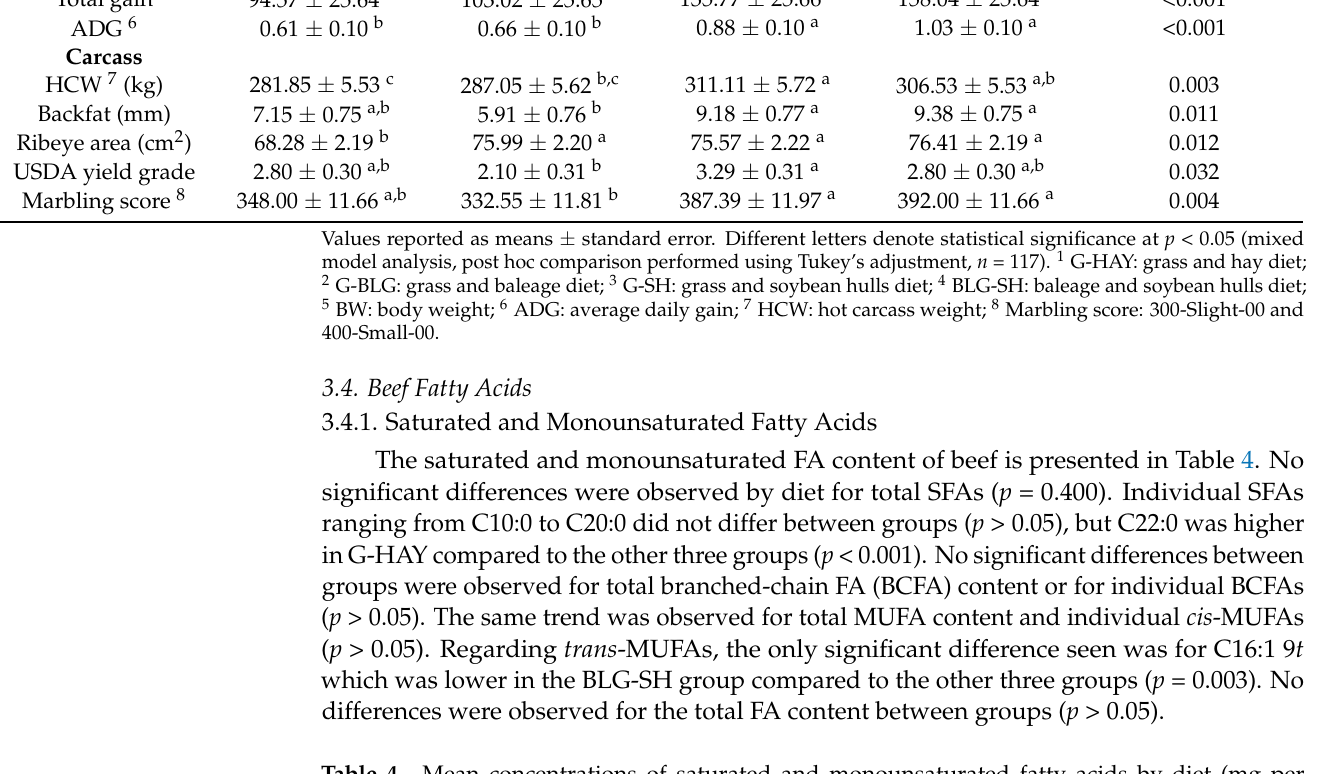
Table 4. Mean concentrations of saturated and monounsaturated fatty acids by diet (mg per 100 g